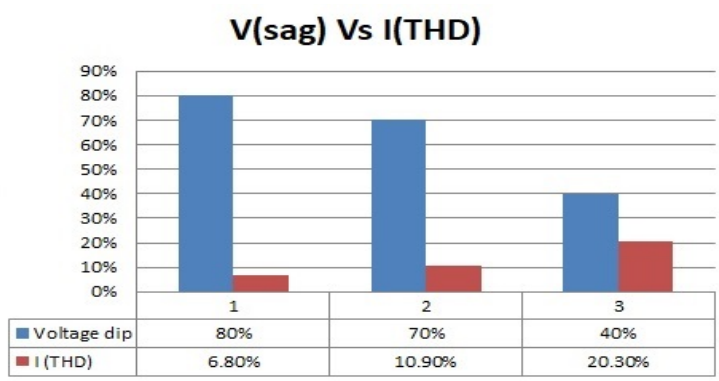
Figure 8. Voltage THD of induction motor under no load conditions [neutral connected].